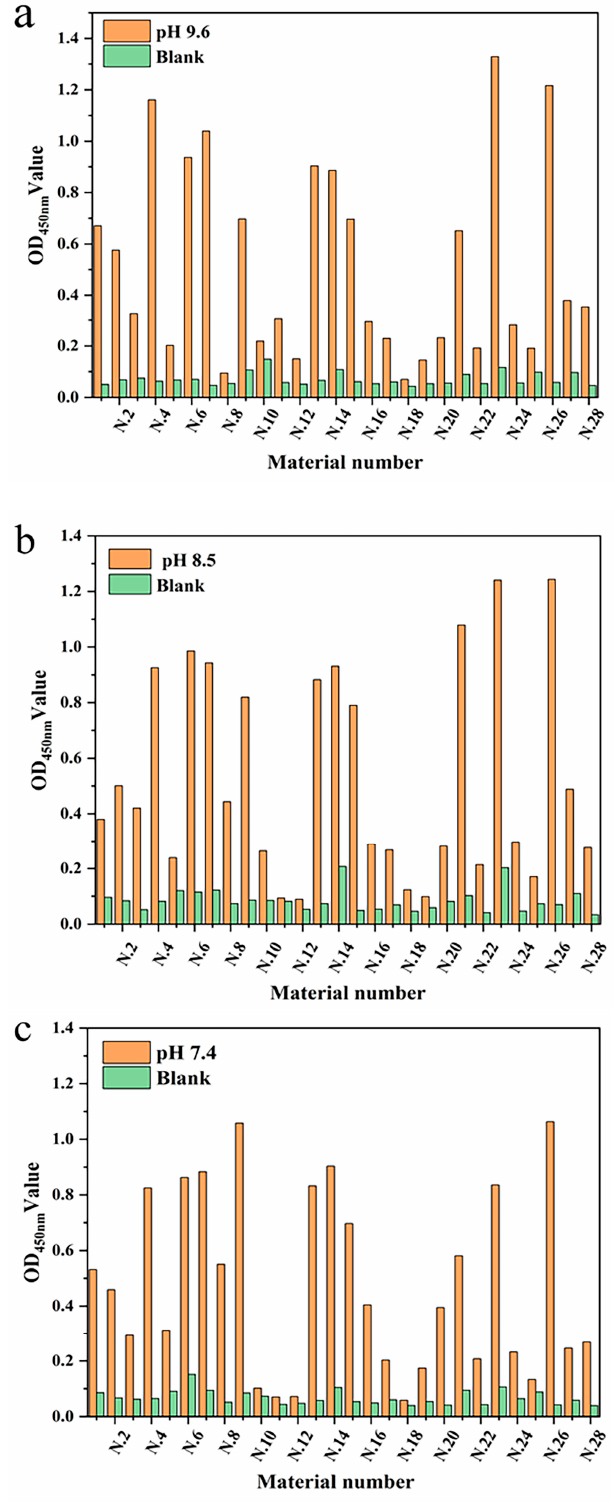
Figure 3. The immobilization effect of antibody protein on linear materials under different buffer conditions: ( a ) Carbonate buffer (pH 9.6); ( b ) Sodium carbonate buffer (pH 8.5); and ( c ) PBS (pH 7.4).